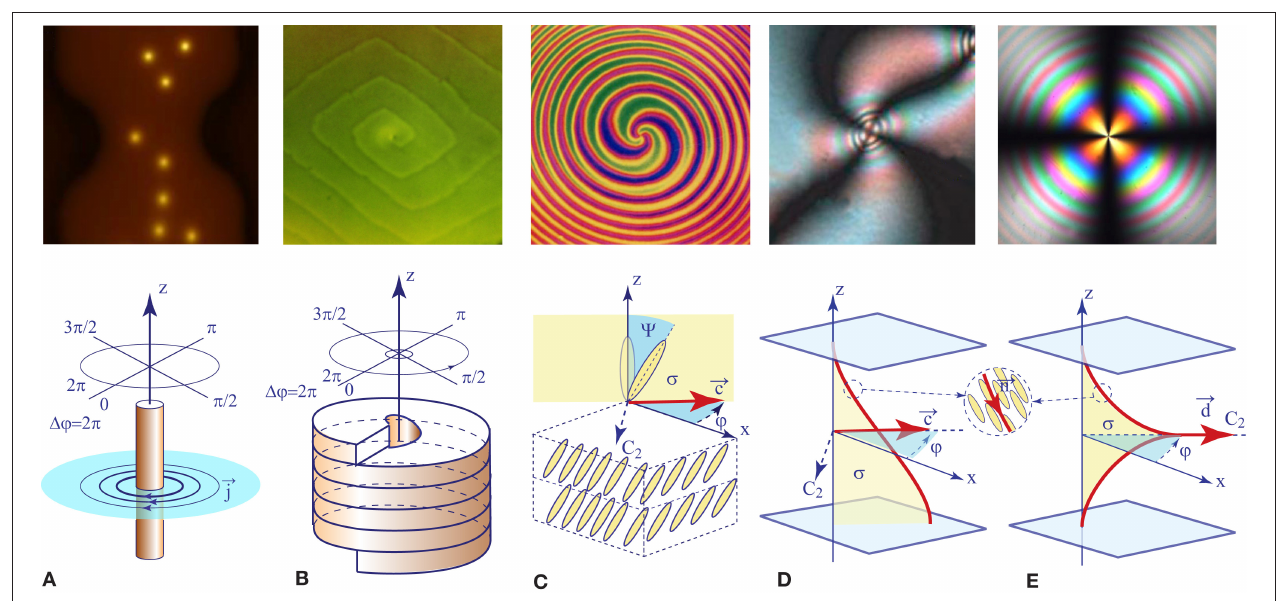
FIGURE 1 | Topological defects in systems characterized by complex order parameters: (A) vortices in a superconductor [2], (B) dislocation in a BPI crystal, (C) disclination in a smectic C free-standing film, (D) umbilic in a homeotropic nematic layer above the Freedericks transition, (E) dowson in the dowser texture.